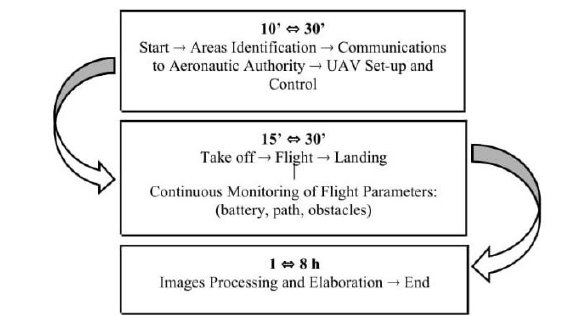
Figure 3. Workflow of a generic flight mission with UAV with relative